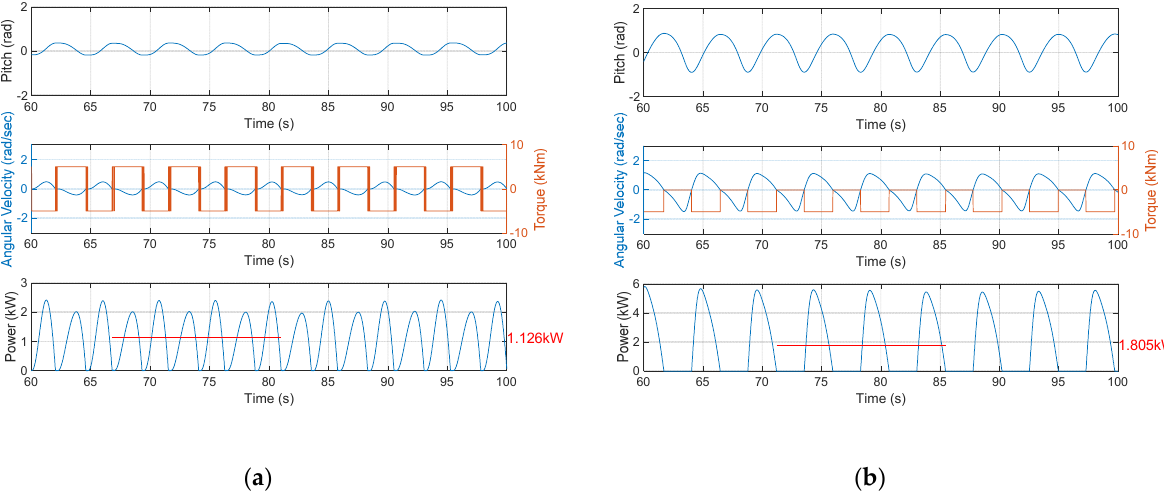
Figure 10. Comparison of the time series of pitch excursion (top), angular velocity (middle), and the extracted power (bottom) at 𝐻 = 0.75 m and 𝑇 = 4.75 s. ( a ) Bi-directional PTO load torque of 5 kNm and ( b ) uni-directional PTO load torque of 5 kNm.